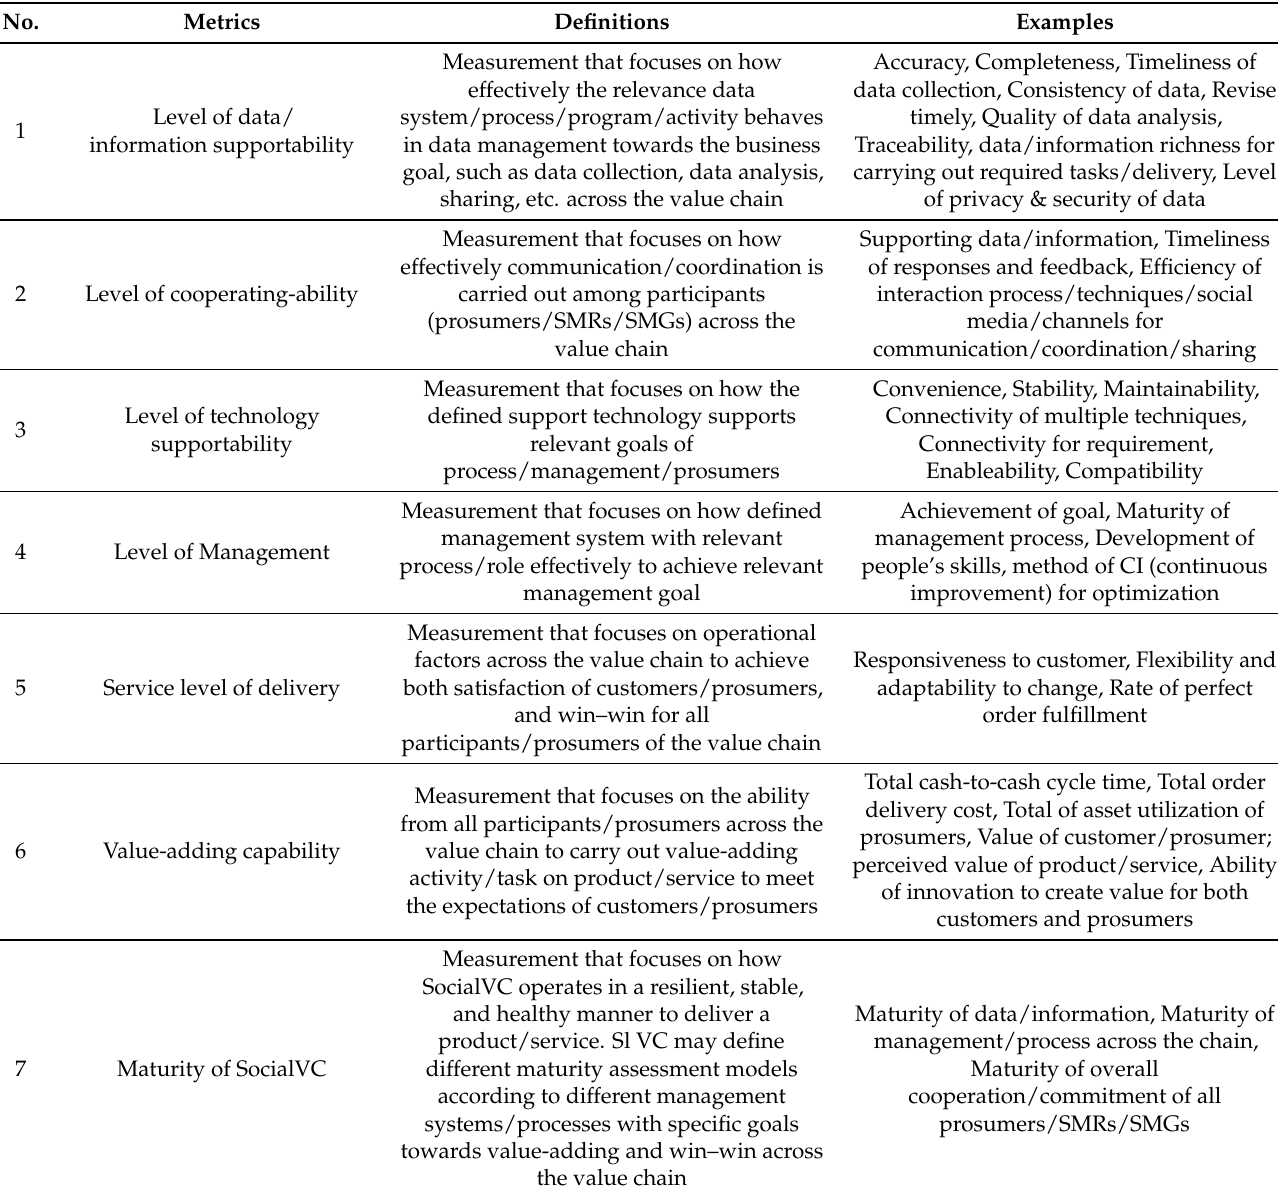
Table 1. Primary measurement metrics of the social value